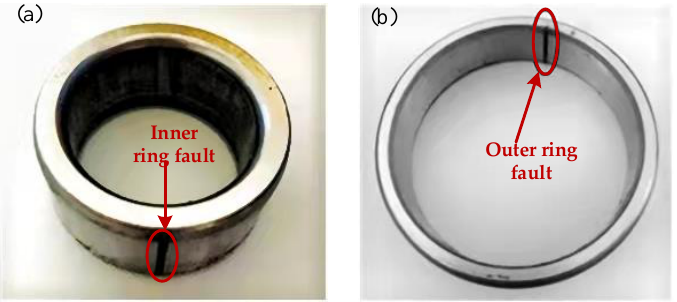
Figure 7. The defect in ( a ) outer surface of inner ring and ( b ) inner surface of outer ring of NU306 bearing.